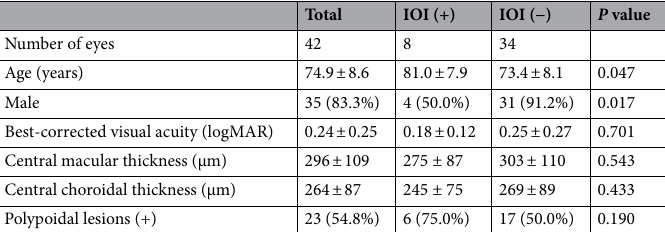
Table 2. Comparison of baseline demographic and clinical characteristics between cases with and without intraocular inflammation after brolucizumab injection. IOI intraocular inflammation.